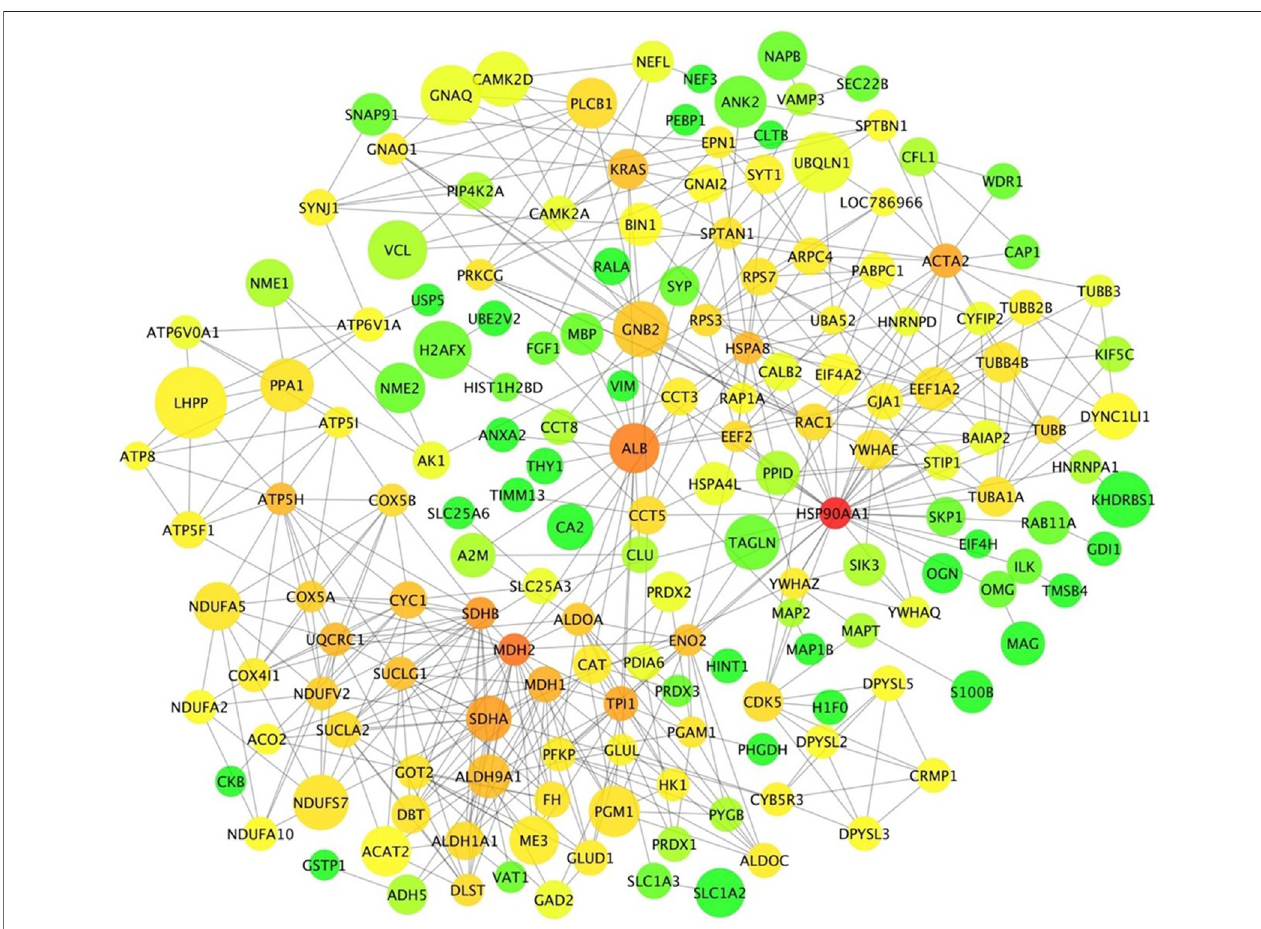
FIGURE7| Protein-proteininteractionnetworkinthehypothalamictissue.Eachnoderepresentsaprotein.Edgesillustratetheinteractionbetweenproteins.Node size represents the level of differential abundance measured for each protein in absolute terms, where bigger nodes represent higher fold changes. Node colour range from green to red represent low to high connectivity in the network for each speci fi c